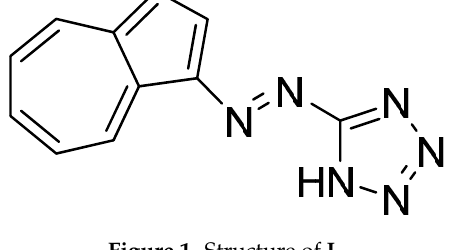
Figure 1. Structure of L .